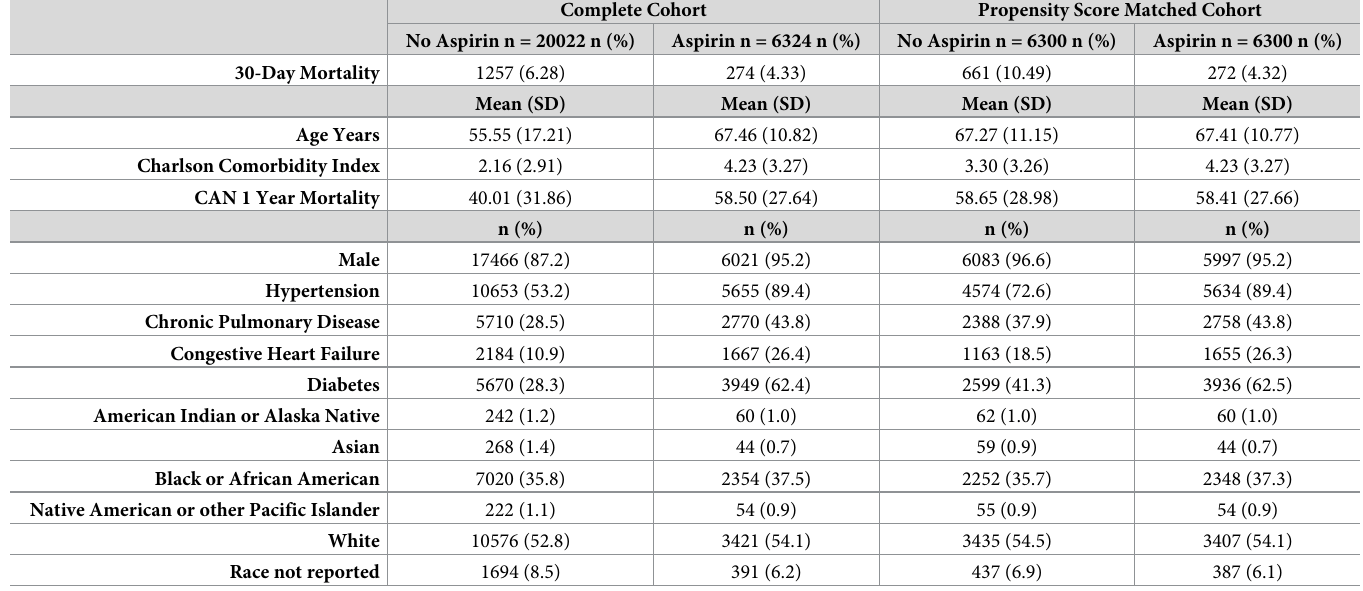
Table 3. Patient characteristics for the 30-day mortality assessment cohort before and after propensity score matching. Complete